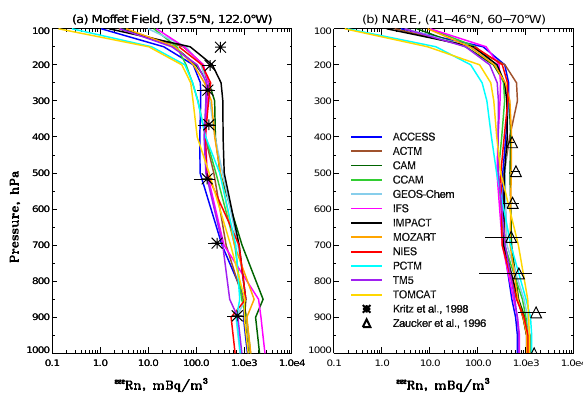
Fig. 8. Comparison of simulated and observed profiles of 222 Rn concentration from (a) the Moffet Field aircraft campaign and (b) the North Atlantic Regional Experiment aircraft campaign. The coloured lines are the results of the different transport models; the black symbols are observations. Horizontal error bars indicate the standard deviations of the observational